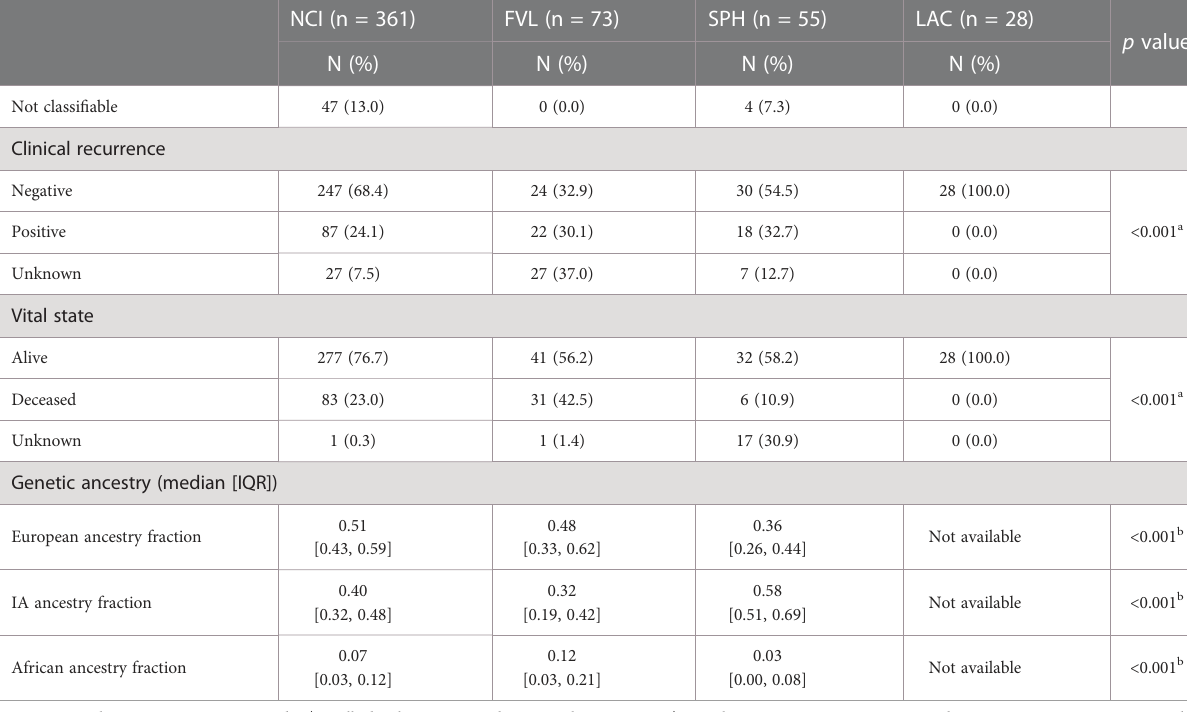
(Supplementary Table S1). Regarding the African component, the co-expression analysis for ER+/HER2+/GRB7- did not show any statistically signi fi cant associations with this ancestry fraction (Supplementary Table S2).